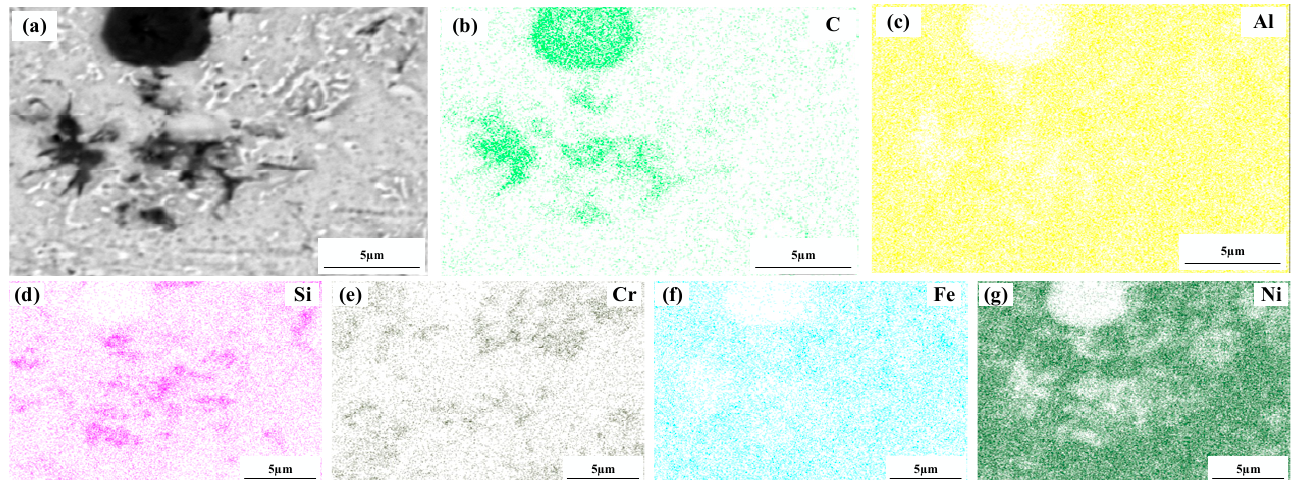
Figure 8. Composition analyses of surface scanning for specimen 4 (1.5% graphene content): ( a ) SEM image; ( b ) C; ( c ) Al; ( d ) Si; ( e ) Cr; ( f ) Fe; ( g ) Ni.